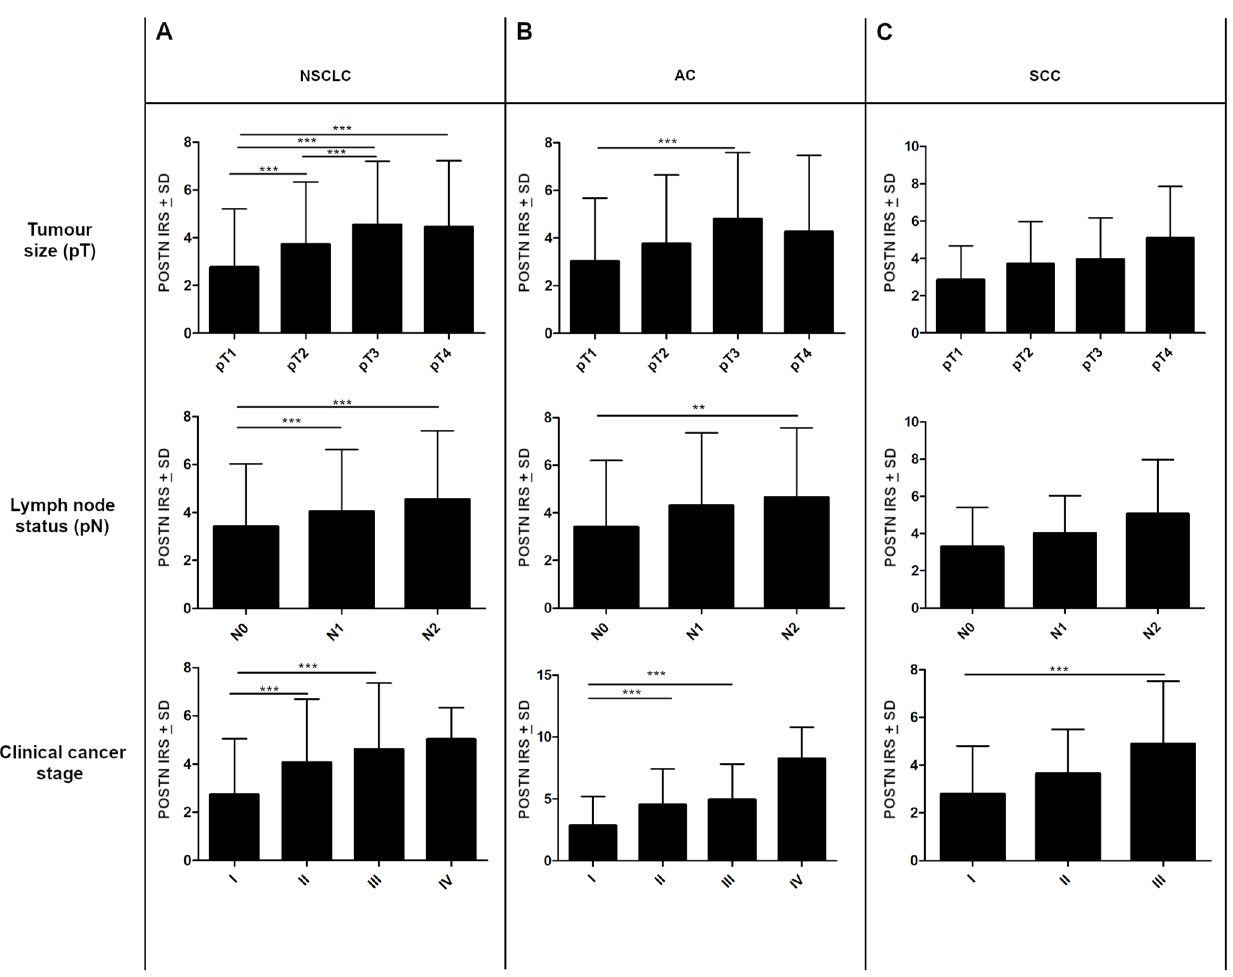
Figure 3. The expression level of periostin (POSTN) in regard to patients’ clinicopathological factors. Comparison of expression levels of POSTN in cancer cells of non-small cell lung carcinoma (NSCLC) with respect to tumor size (pT), lymph node status (pN), and clinical cancer stage in the ( A ) whole study cohort as well as in individual histological types, i.e., ( B ) adenocarcinoma (AC) and ( C ) squamous cell carcinoma (SCC); (** p < 0.005, *** p < 0.001). IRS, immunoreactive score.